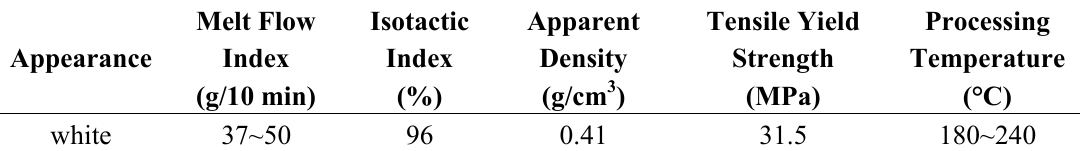
Table 1. Properties of polypropylene.